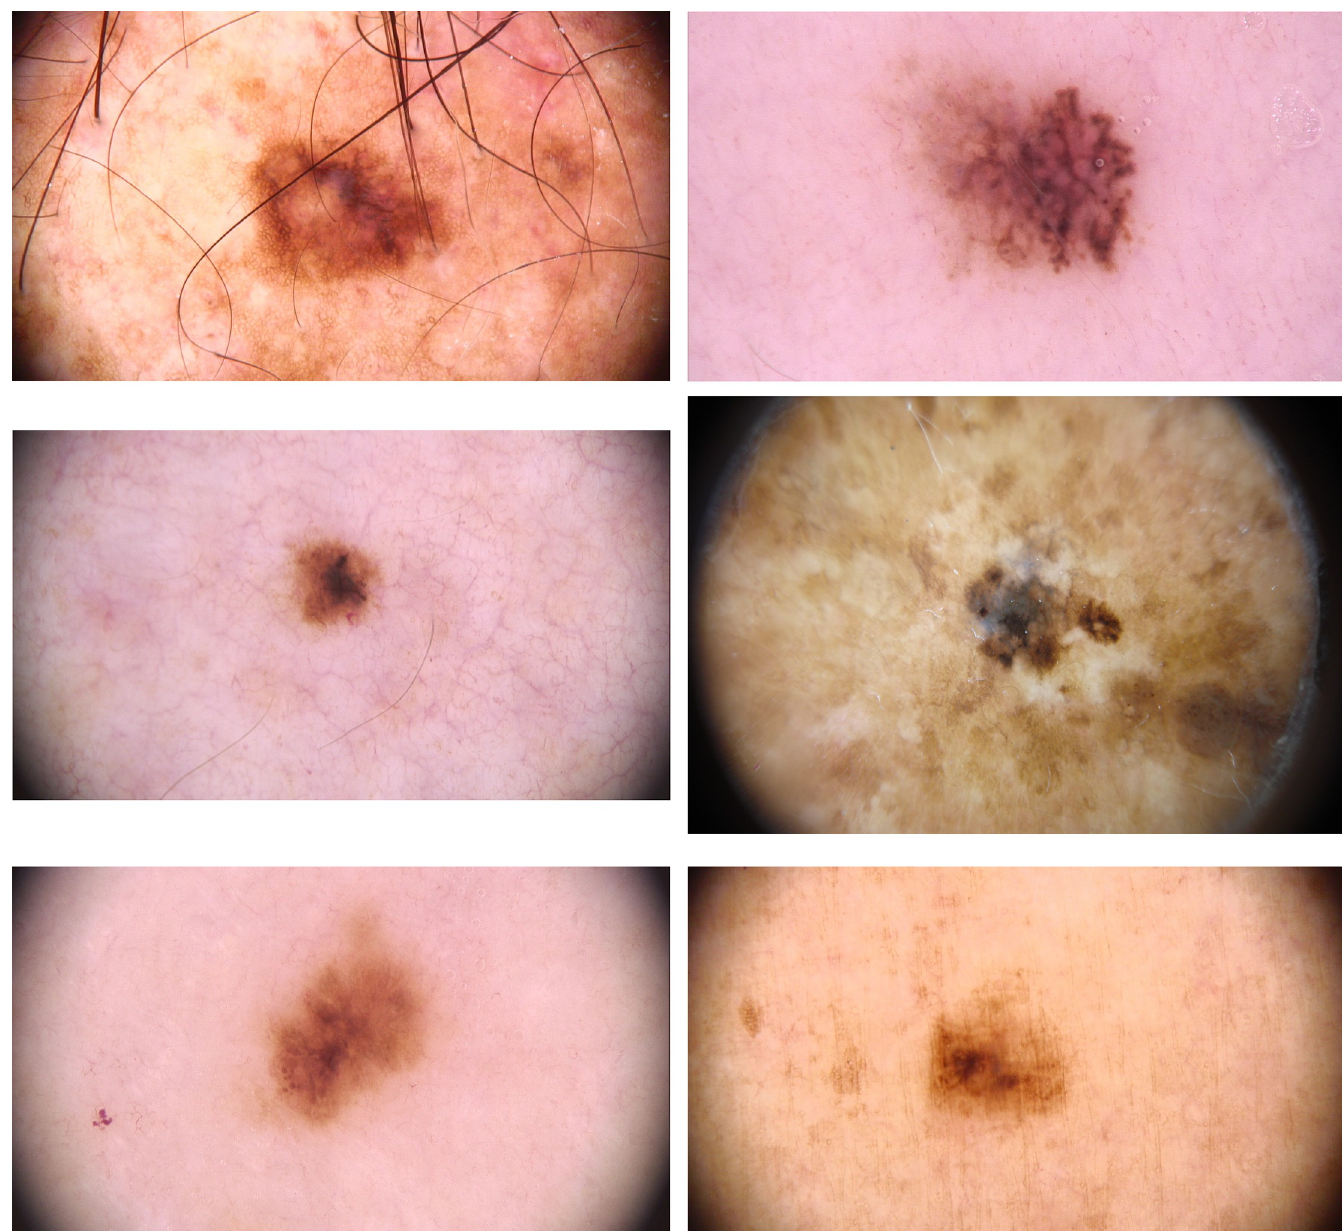
Fig 2. Dermoscopic structures that helped with the diagnosis of some small size melanomas. Fig 2A –Asymmetrical pigmentary network, asymmetric structureless area, blue-whitish veil. Fig 2B –Asymmetrical structureless area and streaks. Fig 2C –Asymmetrical structureless area, asymmetrical globules. Fig 2D –Asymmetrical pigmentary network and streaks. Fig 2E –Blue-whitish veil, asymmetric; asymmetrical pigmentary network. Fig 2F –Asymmetrical pigmentary network and asymmetrical structureless area. https://doi.org/10.1371/journal.pone.0252162.g002 lesions. The accuracy of the iDScore in differentiating early melanoma from atypical nevi in a teledermoscopy setting was tested and compared it with intuitive diagnosis, the ABCD rule and the seven-point checklist. The platform designed for the iDScore project provides ready support for physicians of any dermoscopy skill level and is useful for education and training [31].